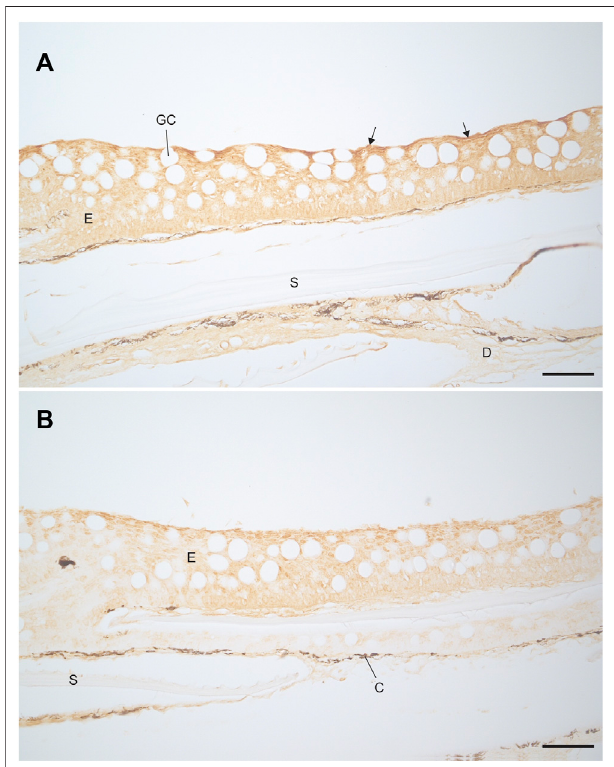
FIGURE 8 | Localisation of V-ATPase in the trunk skin of (A) FW and (B) SW acclimated rainbow trout. Darker staining is visible along the apical epidermal cells of the FW fi sh (highlighted with arrows) compared to the SW fi sh.Scalebar=50 µm.E,epidermis;D,dermis;GC,gobletcell;S,scale pocket; C,